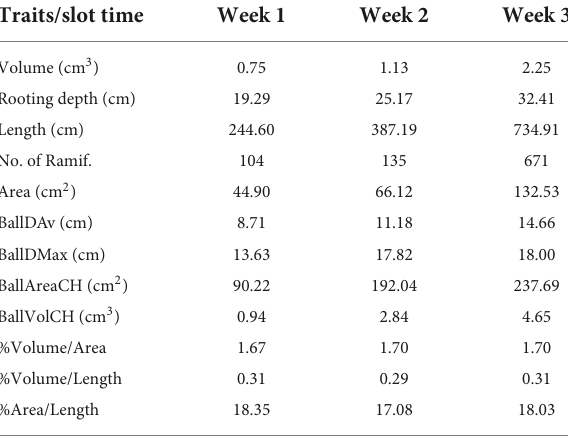
TABLE 2 Total traits computed from a 3-week slot time: volume, depth, length, area, number of ramifications, mean and